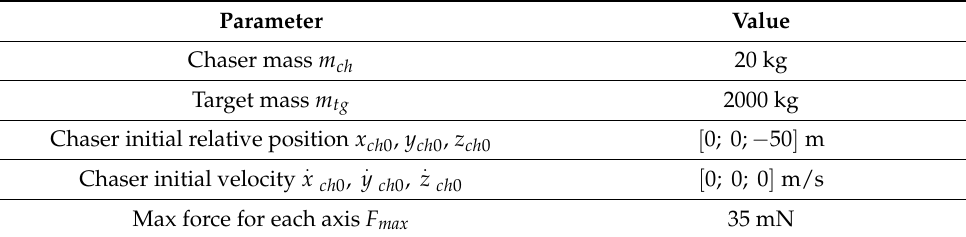
Table 2. Simulation